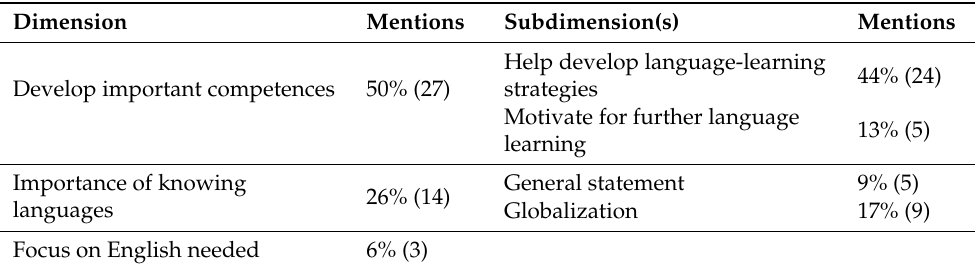
Table 8. Main dimensions and main subdimensions (where applicable) of participants’ cognition about teaching EFL in a way that prepares pupils to learn additional languages. Mentions are given as a percentage of the total number of participants, followed by the absolute number of mentions. More than one theme or subtheme can be present in a single participant’s